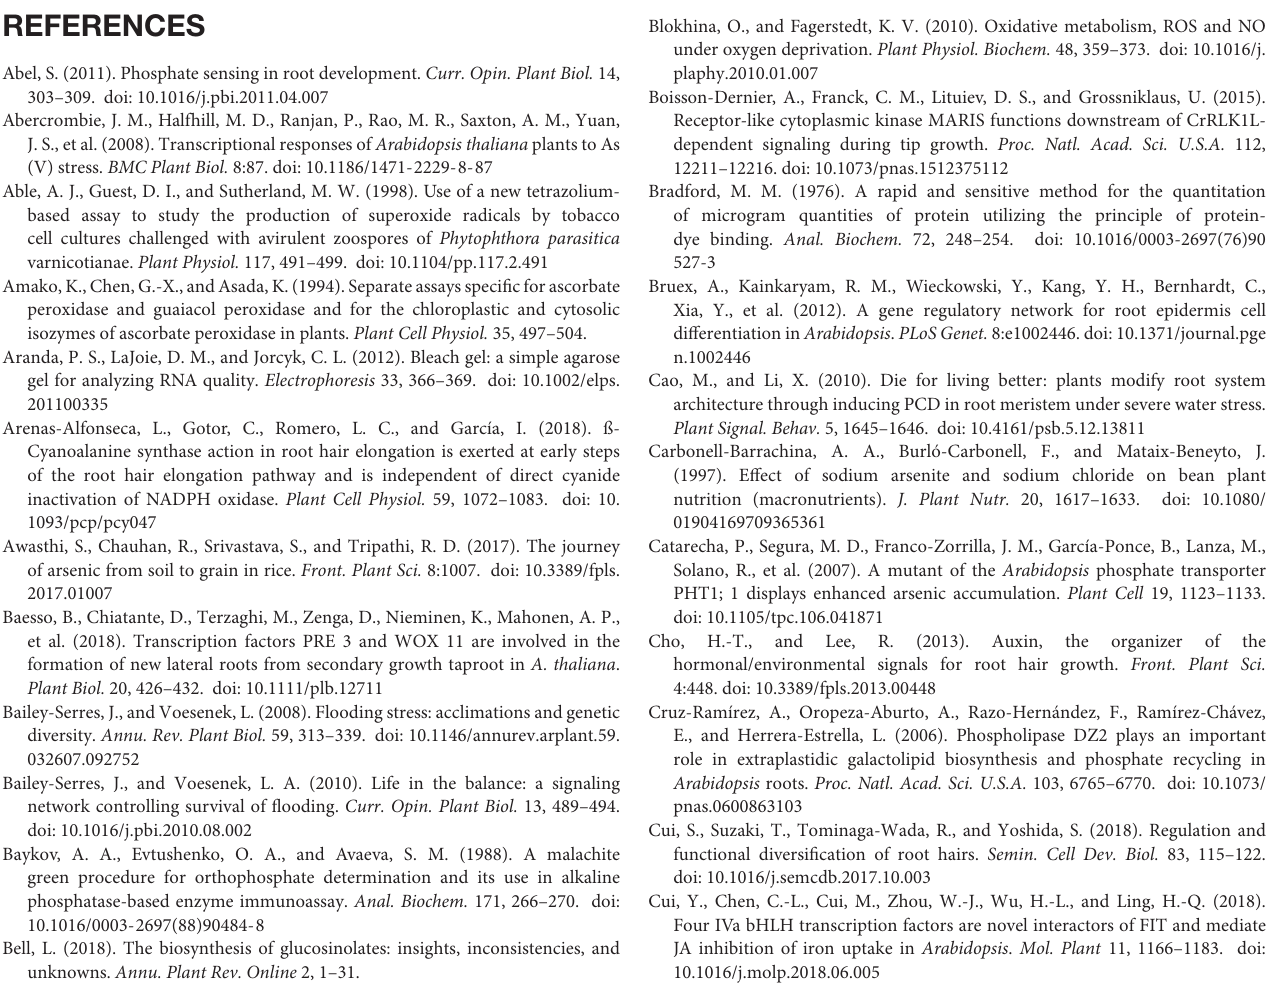
Supplementary Figure 4 | Images from DCFDA fluorescence-based analysis of ROS generation in Arabidopsis roots under As, Hpx and HpxAs. Supplementary Figure 5 | Plant cell sap osmolarity in differentially treated plant roots and leaves. Supplementary Table 1 | Lists of all transcripts related to root and root growth regulation and signaling as influenced by As, Hpx and HpxAs. Supplementary Table 2 | Deregulation of phosphate starvation-related transcripts under applied stresses. Supplementary Table 3 | Lipid biosynthesis and signaling- and phosphatidylinositol metabolism-related transcripts with stress-induced changes in transcript amounts.